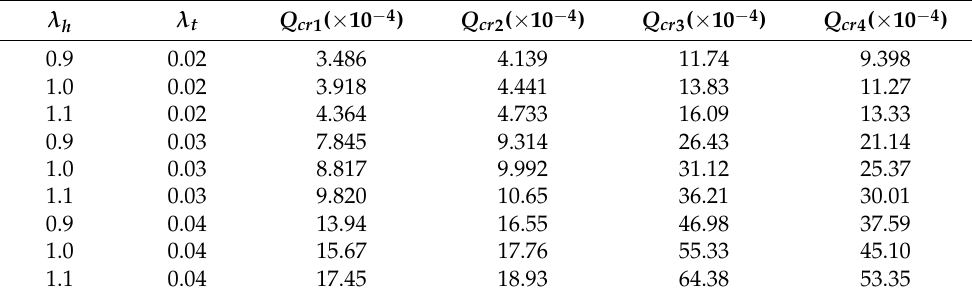
Table 5. Four critical loads under different λ h and λ t ( β = ± 0.15 ).